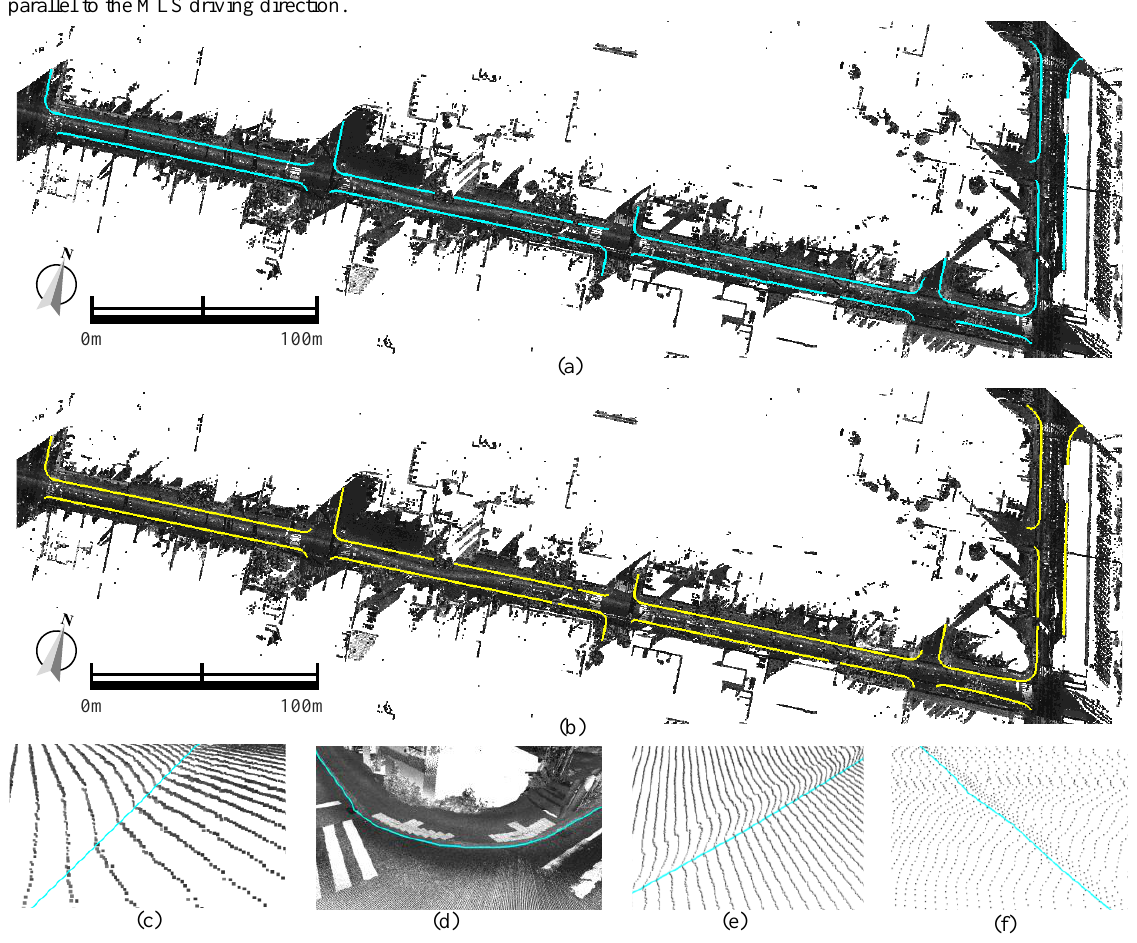
Figure 10. Extraction results of road edges at Sapporo city. Road edge is indicated with the cyan line. (a) Overview of the extracted road edges by the proposed method. (b) Manually extracted road edges for evaluation. (c) Curb cut section. (d) Intersection. (e) Curb section at left side. (f) Curb section at right side.